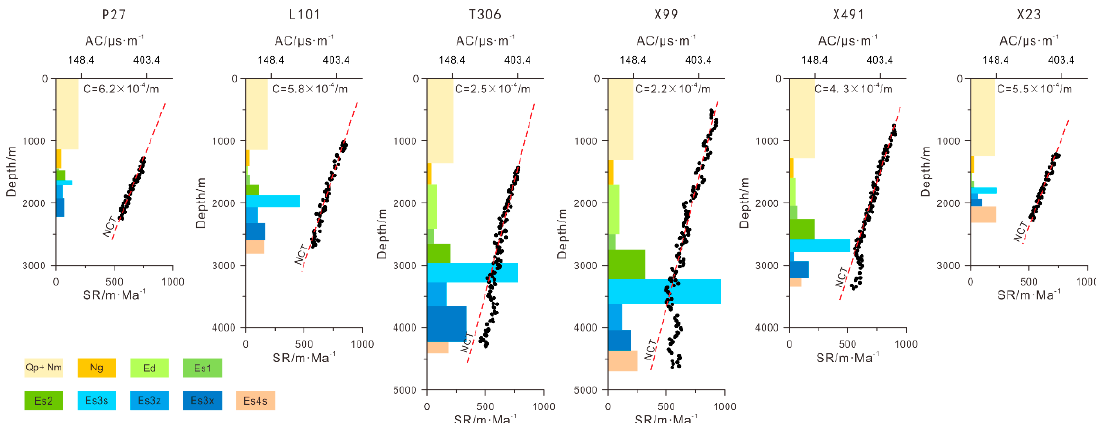
Figure 12. The relationship between the sedimentary rate of formations (colorful rectangles) and compaction curves (black dots) of six wells in the Linnan Sag. The compaction coefficient equals the slope of the normal compaction trend. NCT = normal compaction trend; SR = sedimentation rates; C = compaction coefficient. The locations of the section and the wells are shown in Figure 1C.